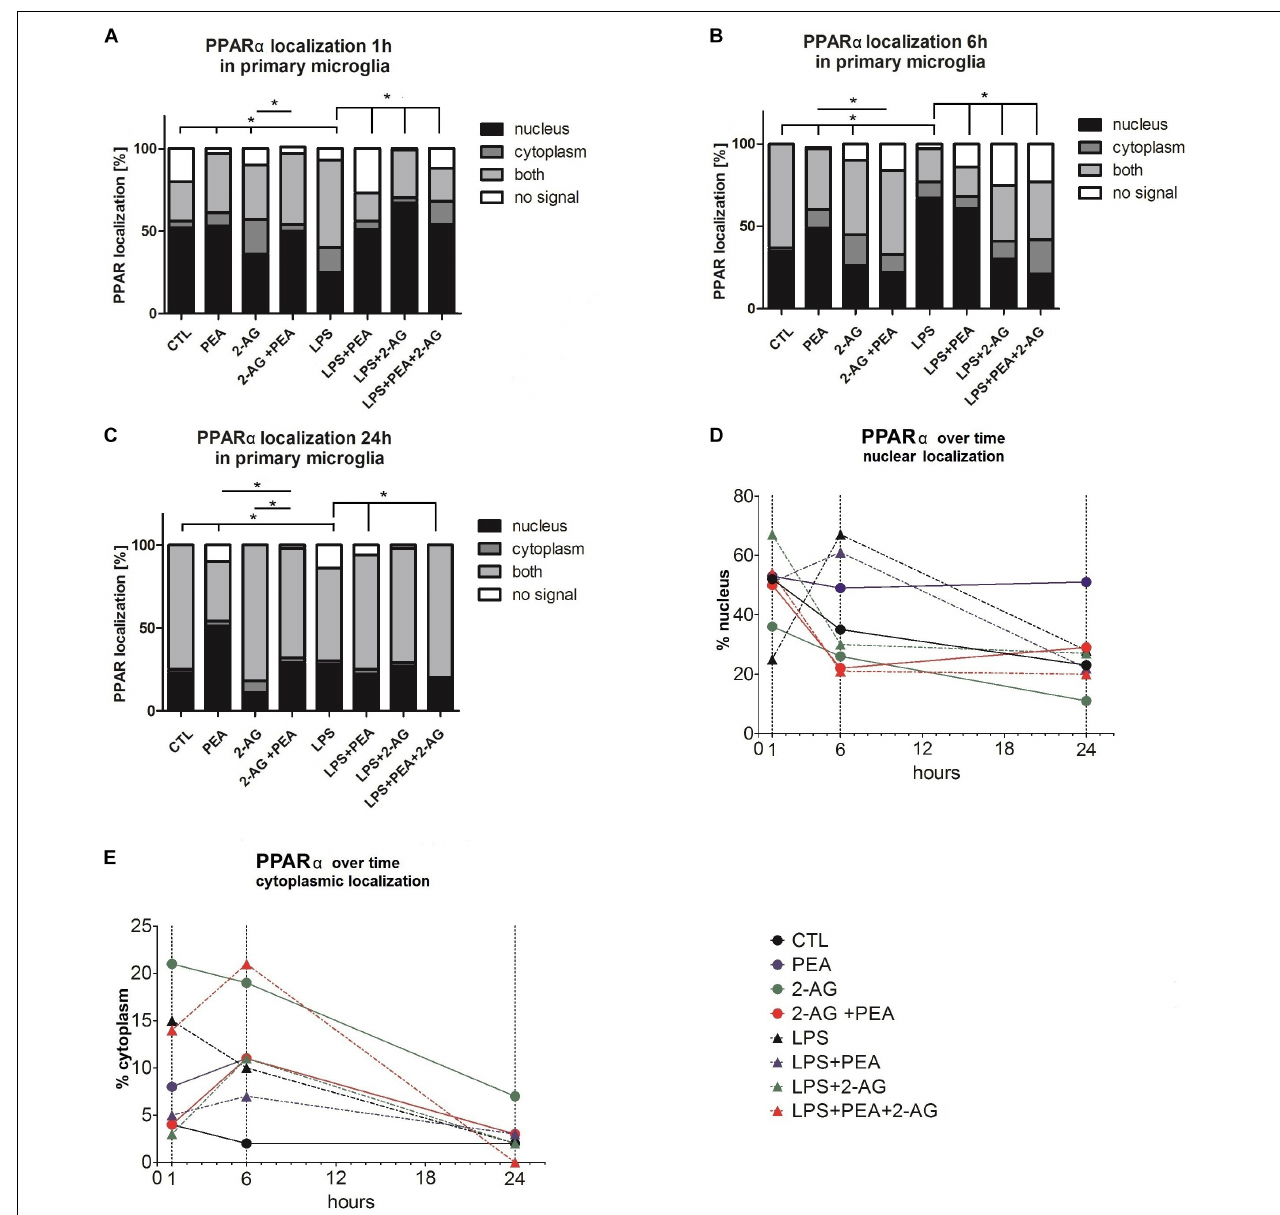
FIGURE 4 | PPAR α subcellular distribution and cellular localization after incubation with 2-AG and PEA in primary microglial cells. The localization of PPAR α was analyzed over time by the use of staining (A–C) 1, 6, and 24 h after treatment, (D) nuclear, (E) cytoplasmic localization (1, 6, and 24 h after treatment). The number of cells which did not or expressed PPAR α in the nucleus or/and cytoplasm was counted. In graphs (A–E) the subcellular location was scored in 483 (1 h), 362 (6 h), and 337 (24 h) cells by light microscopy and presented as percentage. Each independent experiment was repeated at least three times. The same data are displayed in two different ways to point out the differences in the distribution (A–C) between the time points for cytoplasmic and nuclear localization (D,E) . Statistics was performed using a Chi Square test and significance was chosen for p < 0.05. The asterisk denotes significant results regarding the respective measurement indicated with the bar. The values are served as a mean with standard error of the